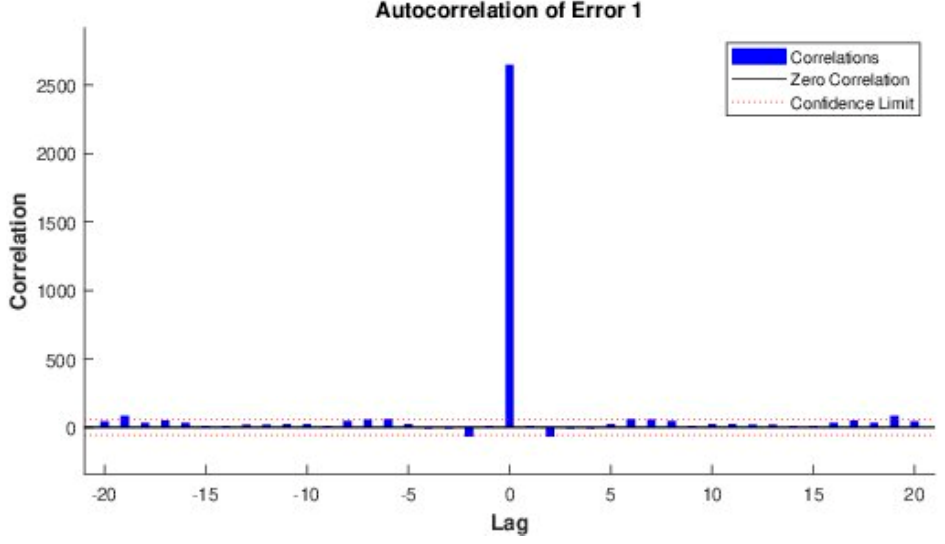
Figure 16. Autocorrelation plot of neural network (solar irradiance forecasting case).